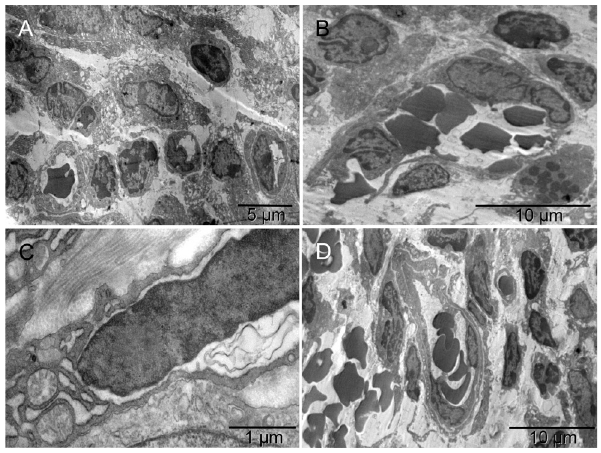
Figure 9. Progress in cellular differentiation and assembly of new vessels. Three weeks after implantation, erythroblasts and megakaryocytes were accompanied by capillaries [ A ]. The close proximity of those three cell types suggested their recent differentiation from common precursors (HSCs) at that location [ A ]. Also evident were forming vessels larger than capillaries, i.e. nucleated cells extending themselves around groups of erythrosomes before completing the enclosure [ B ]. The snail shaped cell in the upper left corner of [ B ] had asymmetrically distributed cytoplasm (a feature of a megakaryocyte) flattened against the abluminal surface of the forming vessel like a podosome, and nucleus partially divided by a radial sinus or invagination of nuclear membrane, suggestive of a potential for stretching. Cells closer to the erythrosomes also had such features. A cell undergoing mitosis is in the lower right corner of the image. Some cells, with ambivalent phenotype that had not specialized into either erythrosome or EC, made collagen in exuberant amounts, comparable to the size of their entire cytoplasm (instead of a few fibers like in Mouse 5) and the nucleus seemed to be converting into an erythrosome on its own [ C ]. However, because those proficient collagen makers were also perishing in the process of tissue building, the result was an area filled with scattered erythrosomes amidst massive amounts of collagen like in the left lower corner in [ D ]. Capillaries and larger vessels were seen side by side [ D